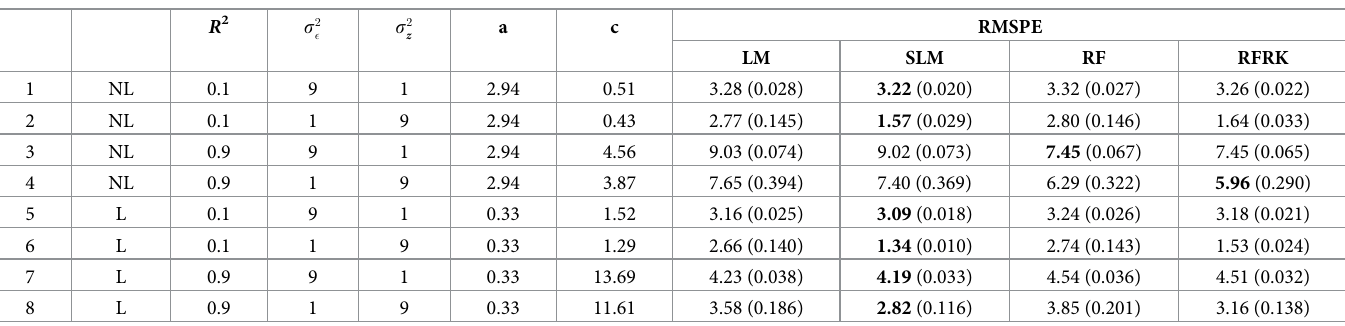
Table 3. Simulation